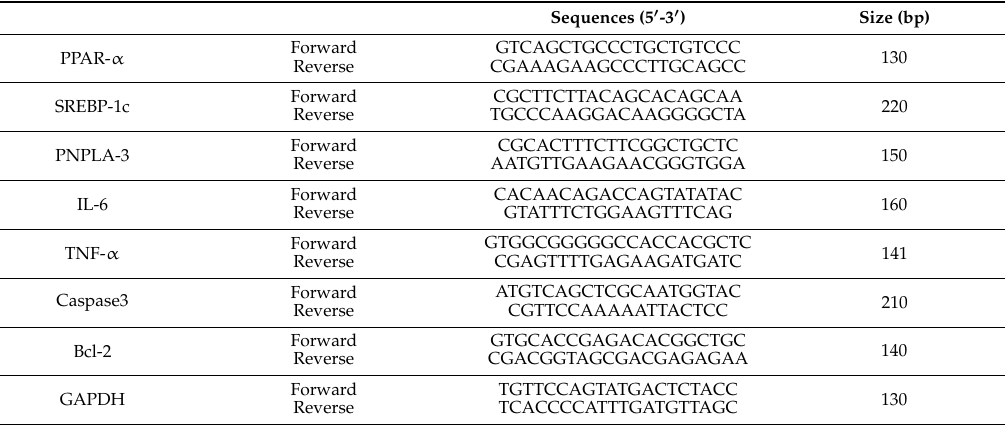
Table 2. The primer sequences used in